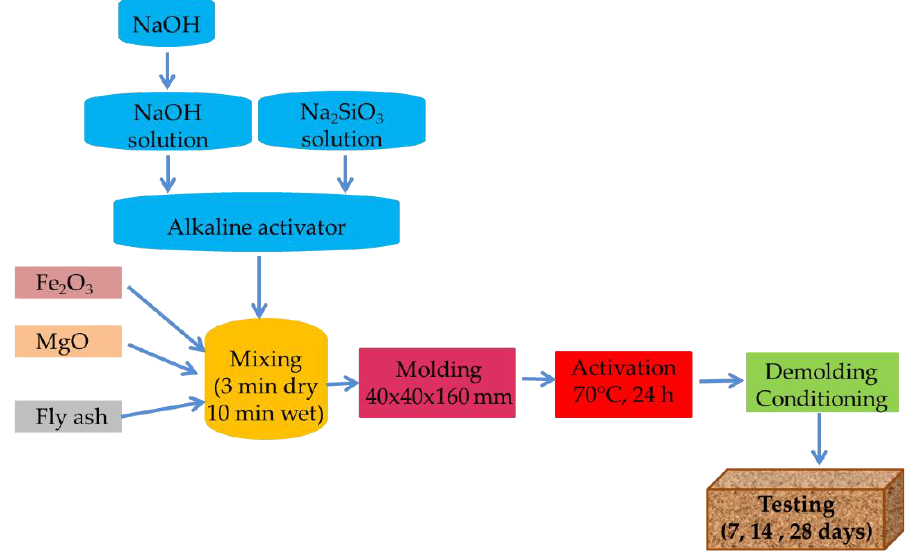
Figure 1. Methodology used for the preparation of the geopolymer